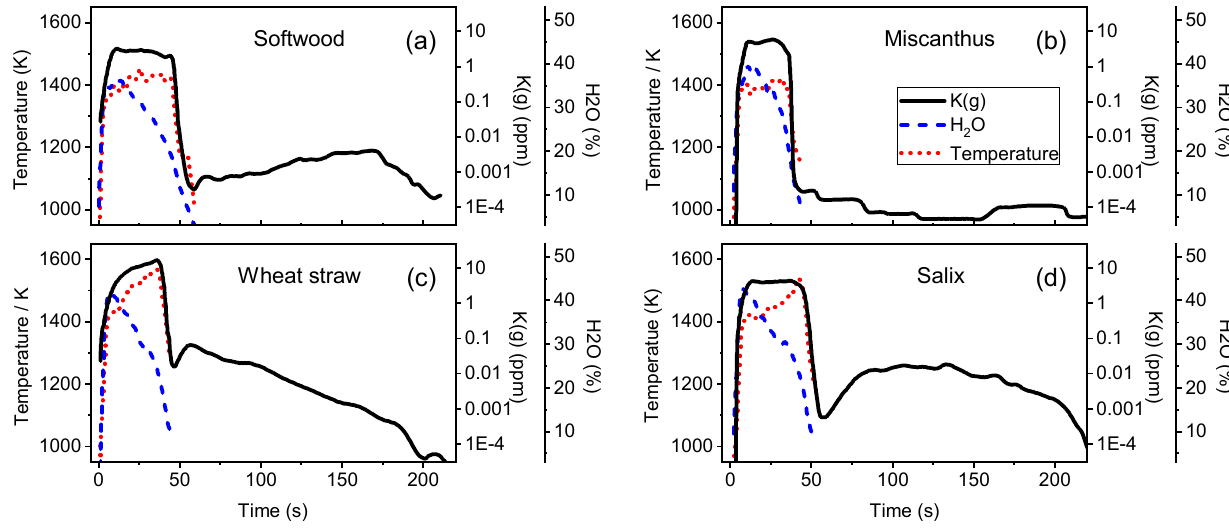
Figure 3. Simultaneous measured K(g) concentration (solid black line), H 2 O concentration (dashed blue line) and gas temperature (dotted red line) at HAP 4 mm above different biomass particles as a function of conversion time. ( a ) softwood; ( b ) Miscanthus; ( c ) wheat straw; and ( d ) Salix.